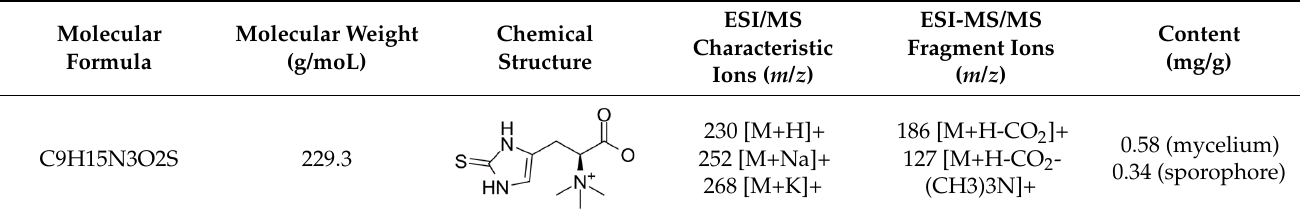
Table 1. Ergothioneine molecular formula, molecular weight, chemical structure, characteristic and fragment ions, and mycelium and sporophore amounts are summarized.